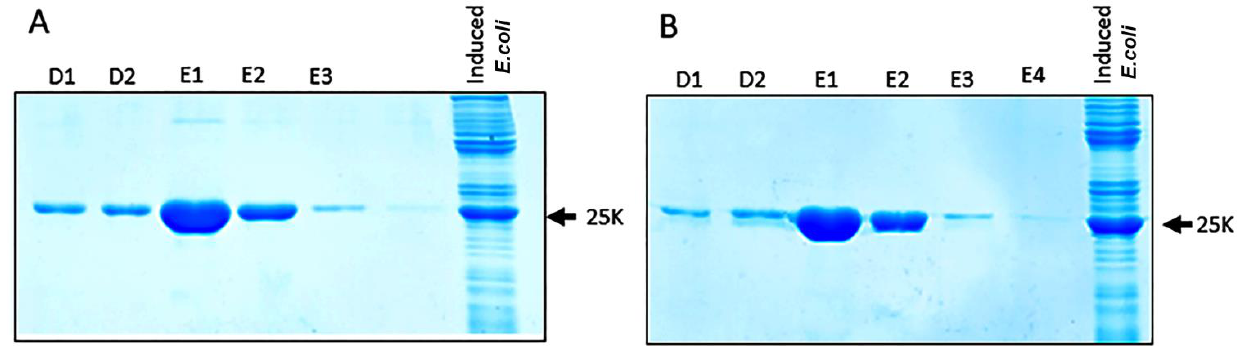
Figure 5. Electrophoretic analysis in 15% polyacrylamide gel of the protein fractions eluted from the Ni-NTA column: ( A ) fused DHFR- ep1 protein; ( B ) fused DHFR- ep2 protein. The outermost right lane demonstrates the level of epitopes’ expression after the induction relative to total protein in Escherichia coli. D1-D2 и E1-E4 designate 0.5 mL successive fractions elution with D and E buffer solutions (see Materials and